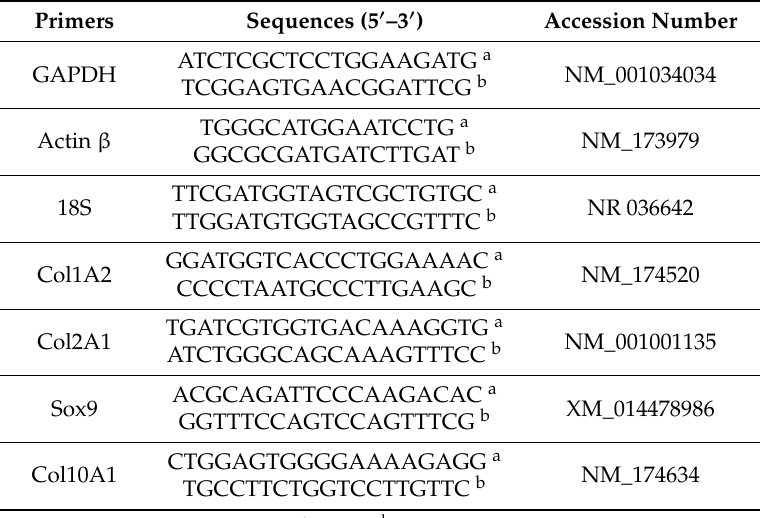
Table 2. Oligonucleotide primers used in this